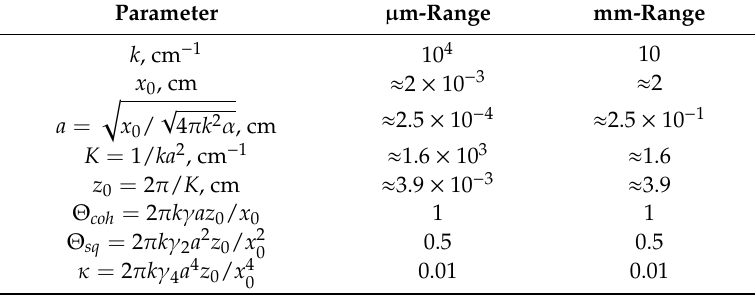
Table 1. Preliminary estimates for waveguide and wave packet parameters for the generation of coherent and spatially squeezed states.